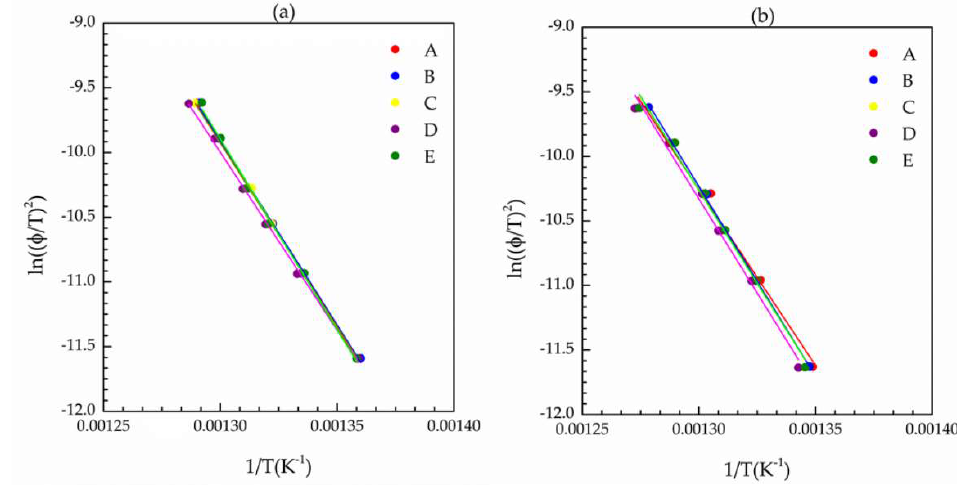
Figure 4. TGA curves of the insulation layer for virgin and naturally aged cables, under condition II (heating rate of 25 ◦ C min − 1 ). A–E stand for different ESP cables as denoted in the Section 2.